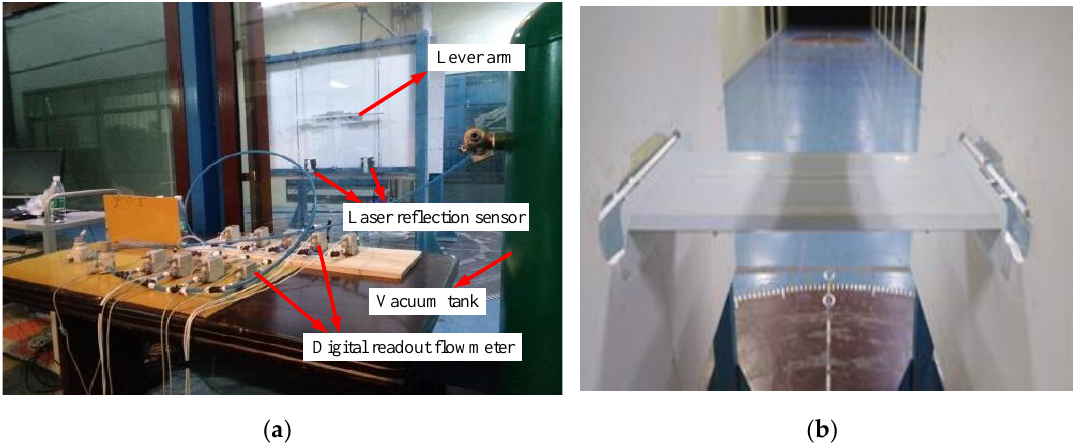
Figure 3. Experimental setup: ( a ) steady-suction device and ( b ) section model.